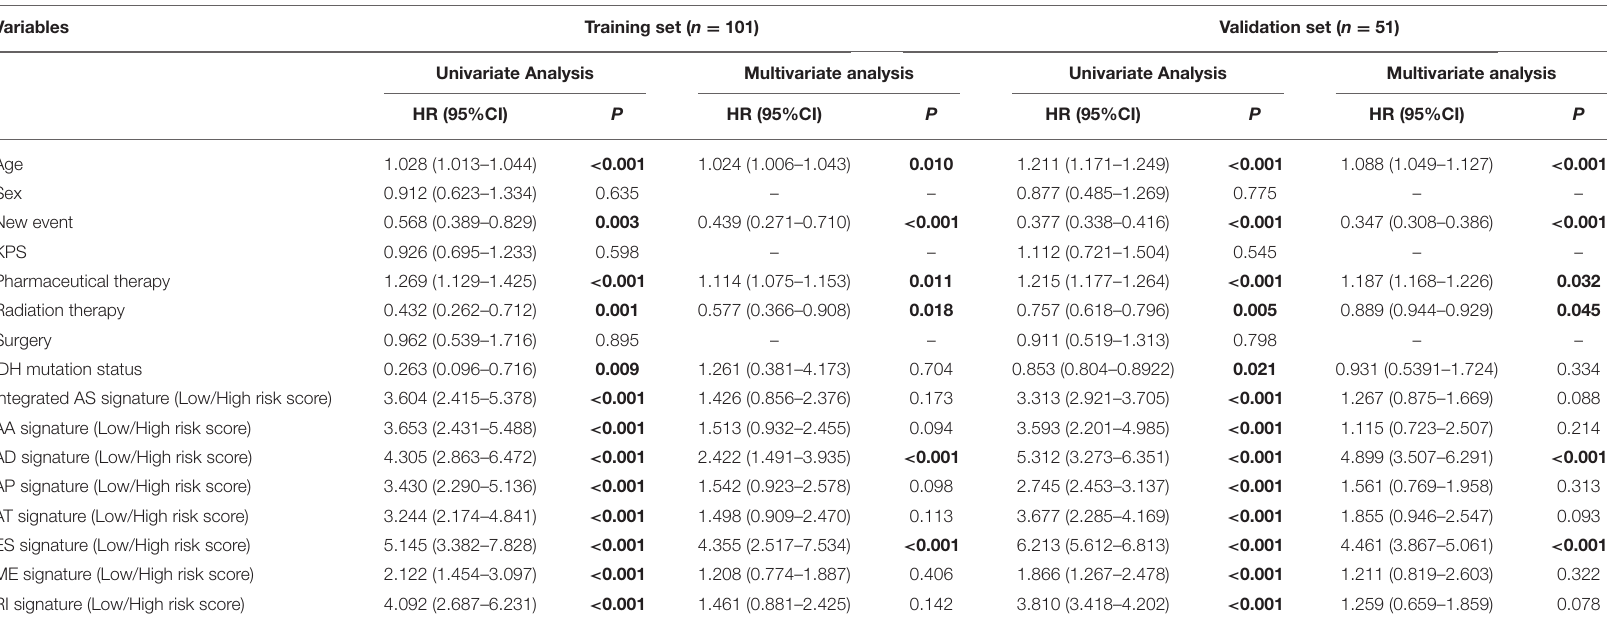
TABLE 3 | Univariate and multivariate cox proportional hazards analysis of clinical parameters and AS event-based risk score model of the TCGA GBM patients in the training cohort ( n = 101) and internal validation cohort ( n = 55).